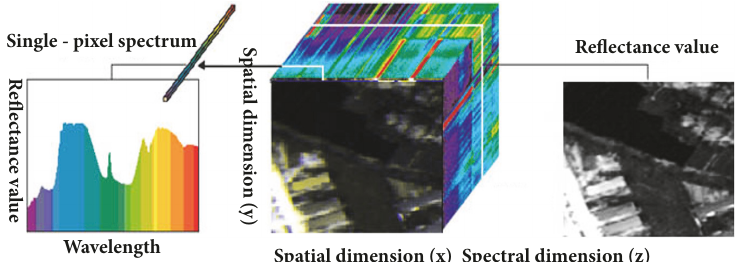
Figure 1: The example of hyperspectral image data